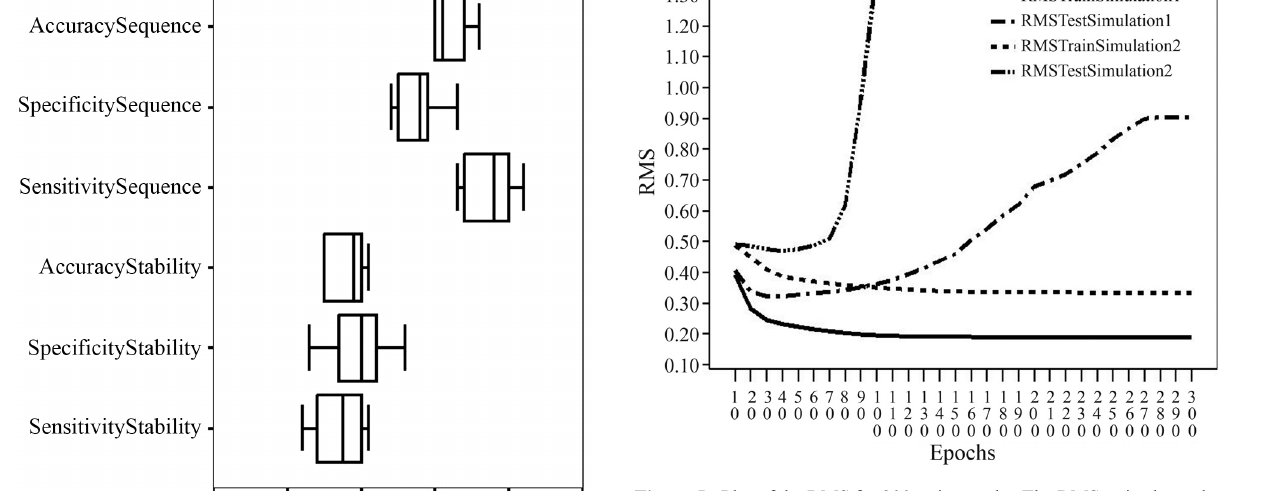
Figure 5 - Plot of the RMS for 300 train epochs. The RMS train showed a slow decrease in both simulations. In this test, the lowest RMS value was observedatepoch30inthesequence-basedsimulationandepoch40inthe stability-based